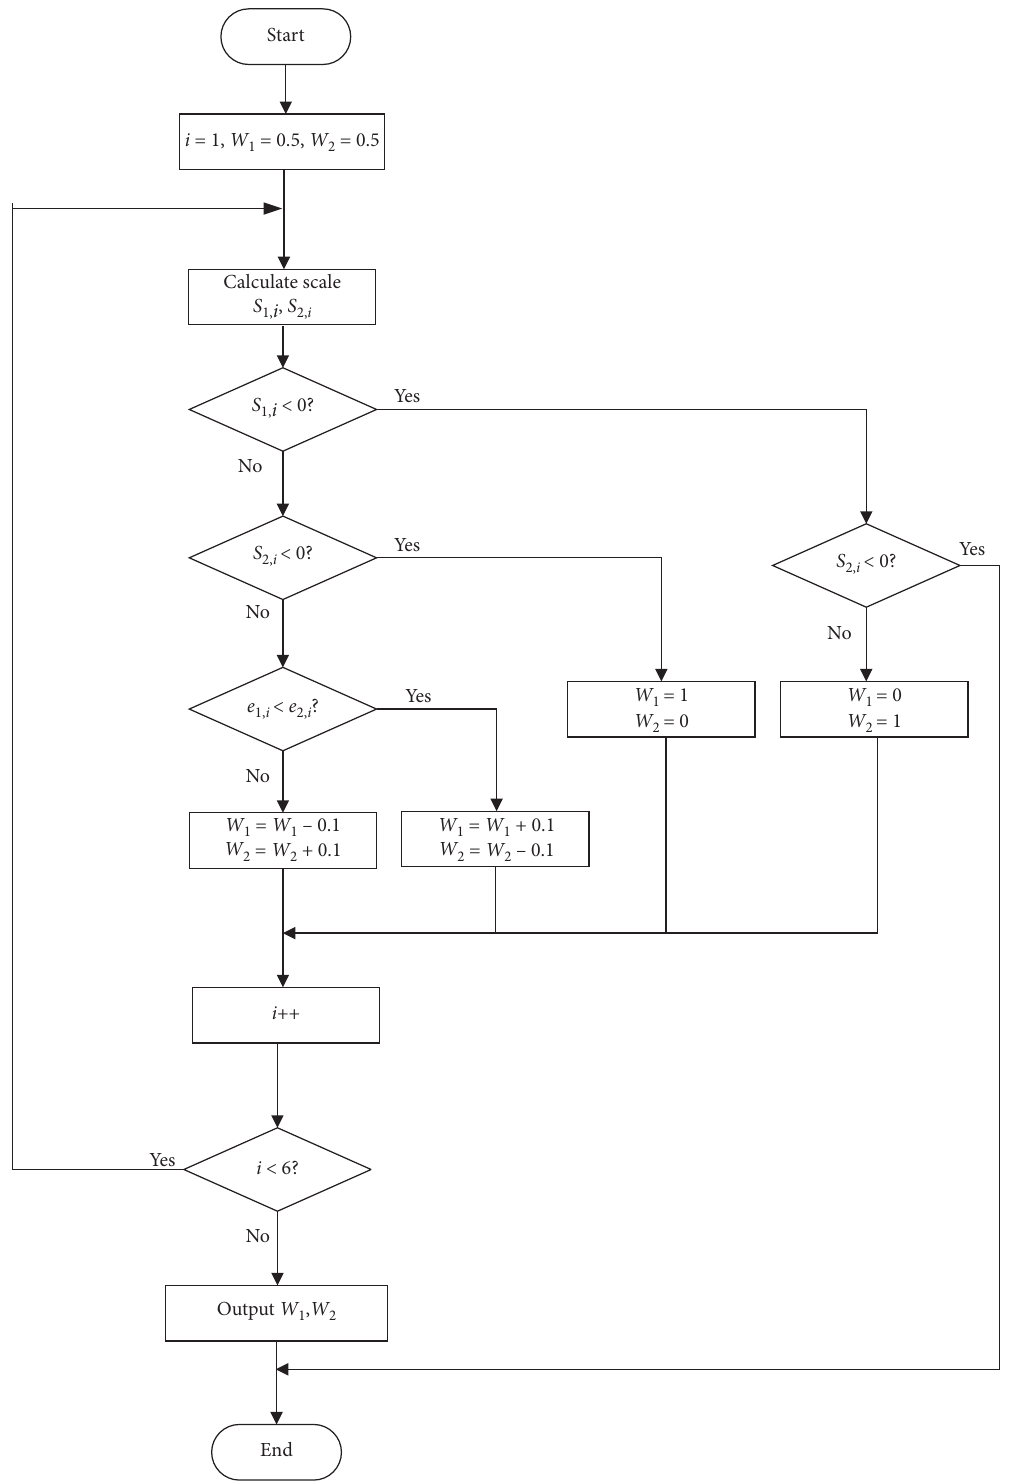
Figure 3: Dynamic weighting